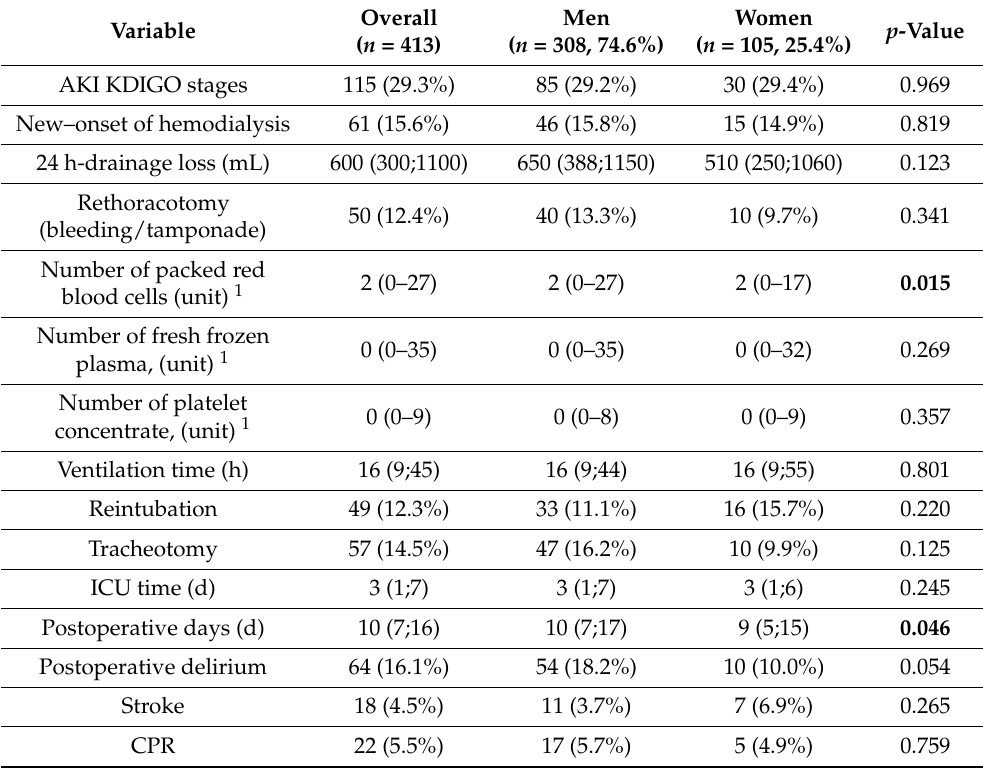
Table 3. Postoperative data and outcomes stratified by